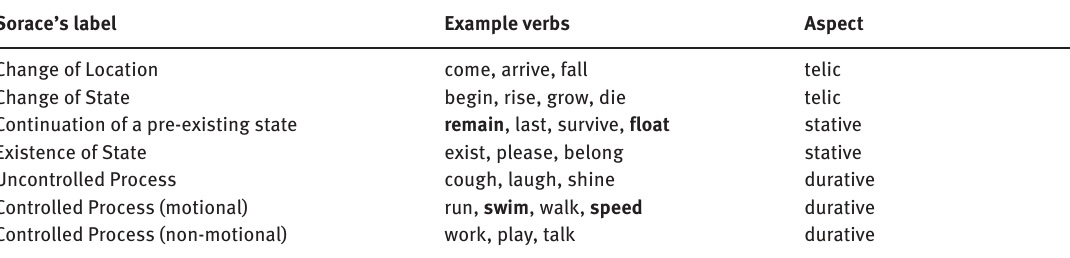
Table 2. Sorace’s continuum between unaccusative and unergative Sorace’s label Example verbs Aspect Change of Location come, arrive, fall telic Change of State begin, rise, grow, die telic Continuation of a pre-existing state remain , last, survive, float stative Existence of State exist, please, belong stative Uncontrolled